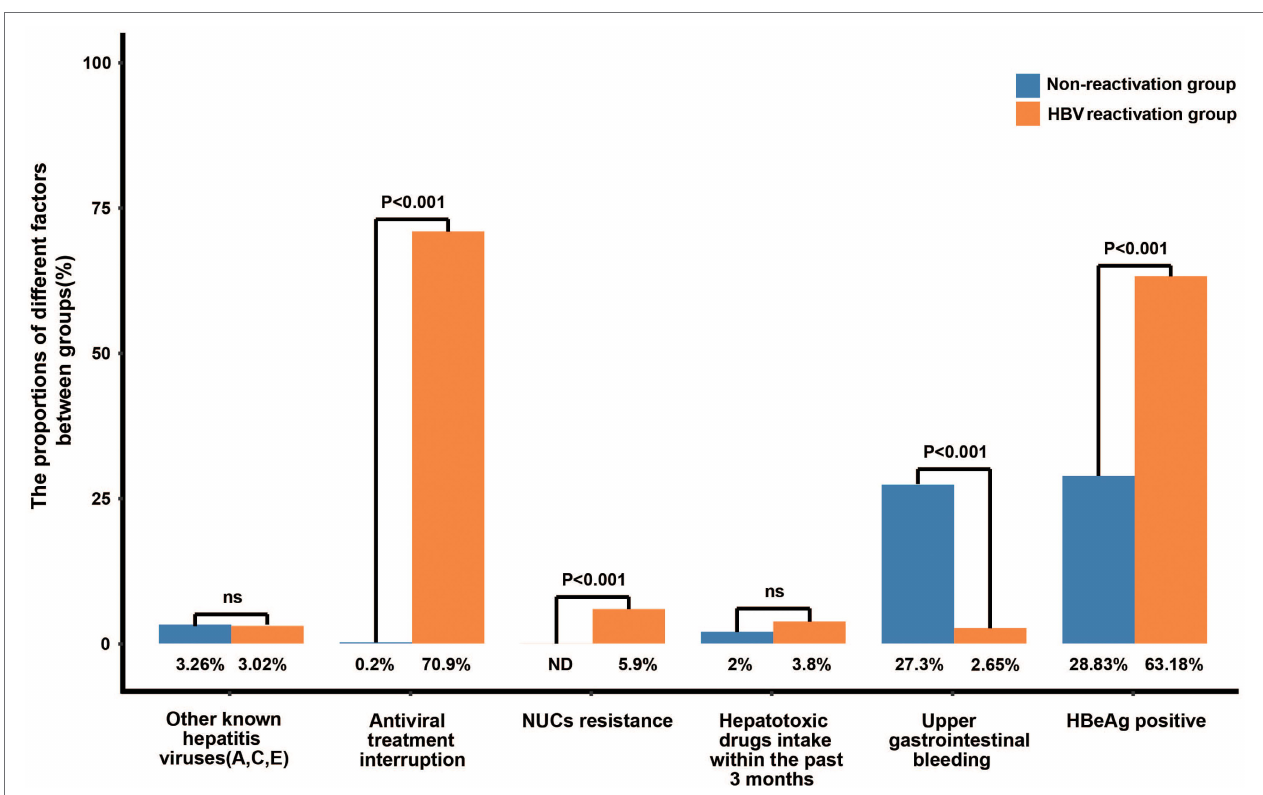
FIGURE 2 | Risk factors of HBV reactivation in CHB